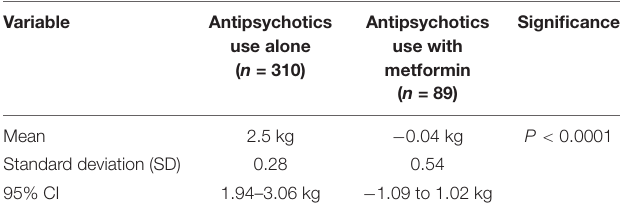
TABLE 2 | Comparison between mean of weight change between antipsychotics alone vs. antipsychotics with metformin.